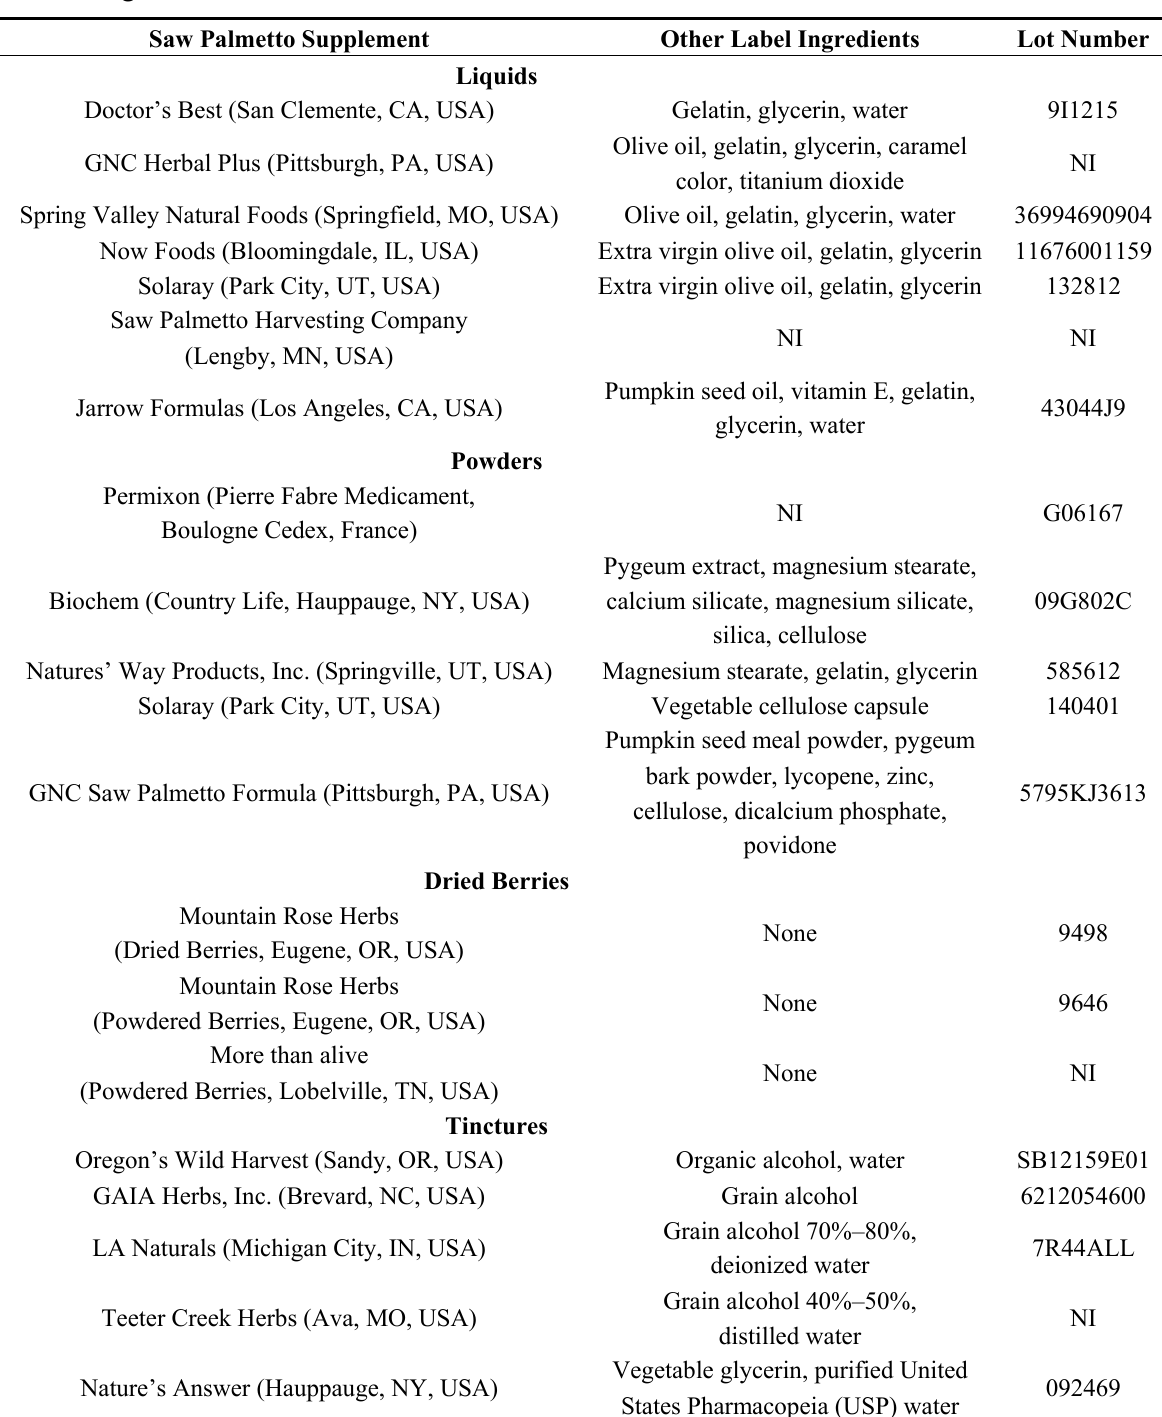
Table 1. Saw palmetto supplements’ names, manufacturing locations, and other label